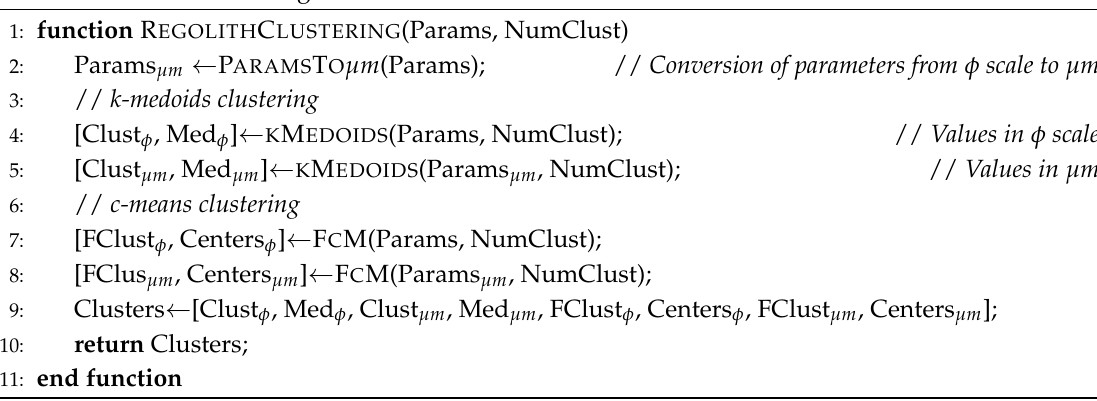
Algorithm A3. Clustering the parameters of the mixture approximation of the particle size distributions of the lunar regolith